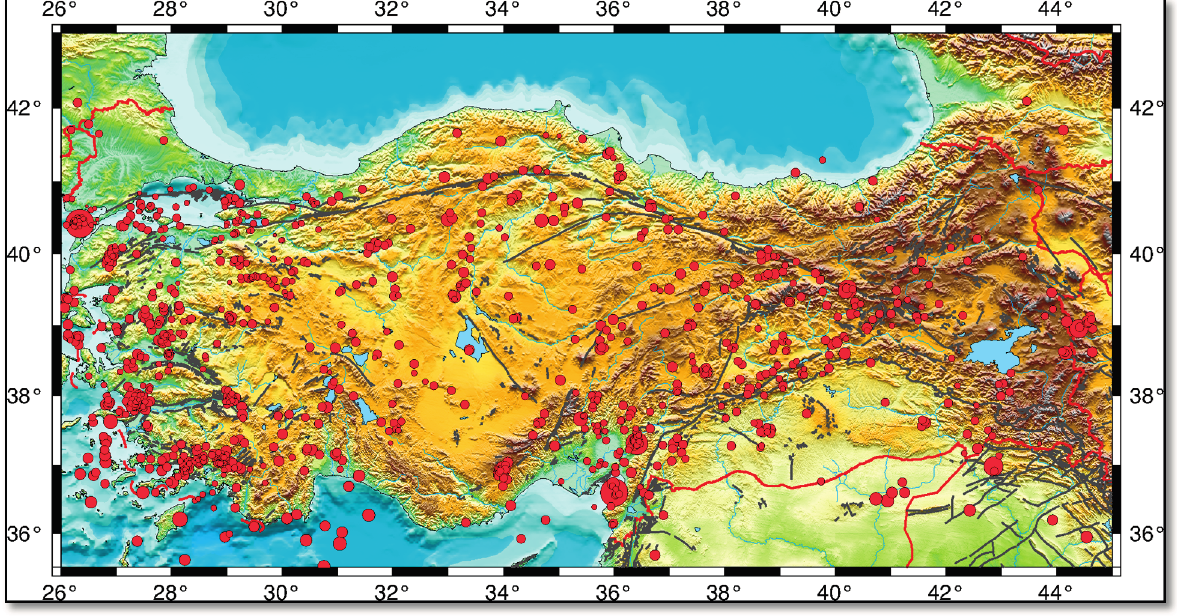
Figure 2. Seismicity of Turkey and surroundings. Red circles mark earthquakes. The circle size is proportional to the magnitude of the earthquakes (magnitude equal to and larger than 4.0) [7]. Bold black lines indicate the faults [8]. The figure is generated by the Generic Mapping Tools (GMT) package of Wessel and Smith